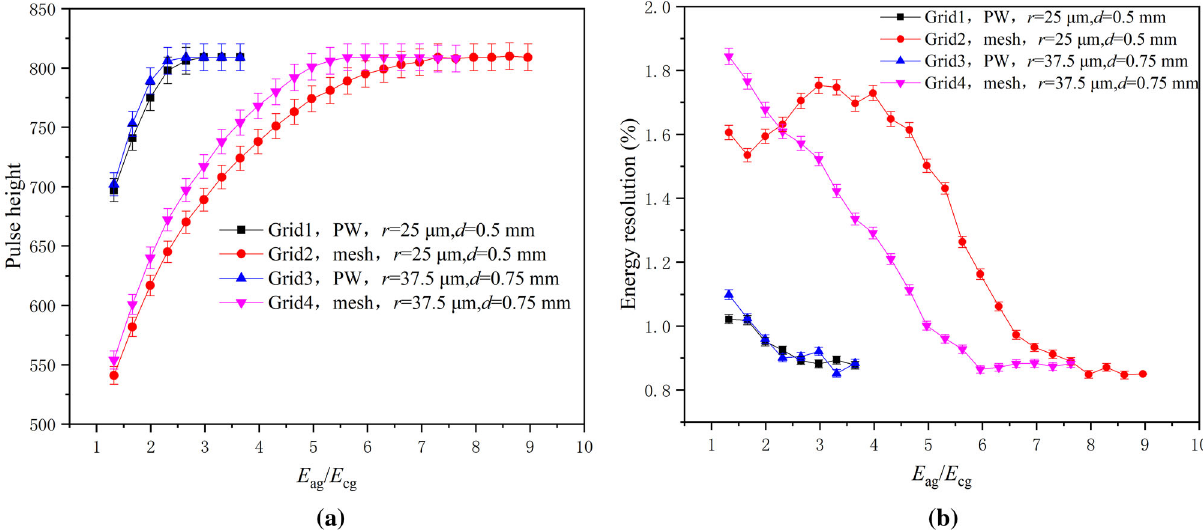
Fig. 5 Graphs showing the anode pulse height ( a ) and chamber res- olution ( b ) as functions of E ag / E cg when using four different grids. The different grids are denoted by different symbols. The error bars are